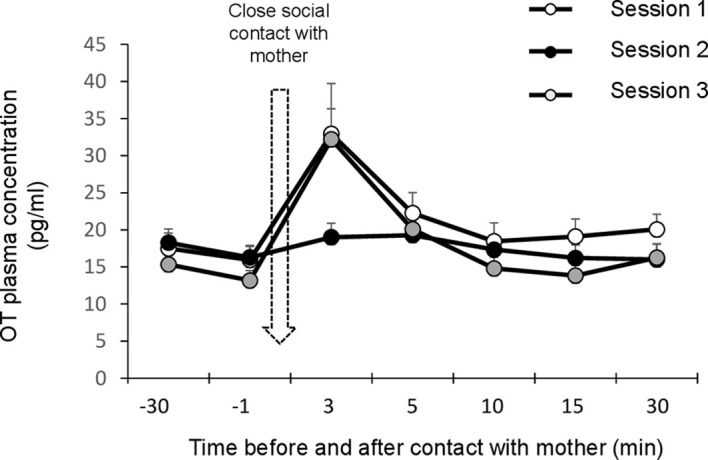
Effect a 3-min period of close social contact with the mother (arrow) on plasma oxytocin levels. Lambs (n=7) were separated from their mothers by a wire mesh before and after being reunited with the mother for 3 min. Samples were taken 30 min and 1 min before close social contact, and then 3, 5, 10, and 15 min later, in three consecutive sessions three days apart. Session 1: suckling permitted. Session 2: contact suckling prevented. Session 3: suckling permitted. Data are expressed as means and s.e.m.